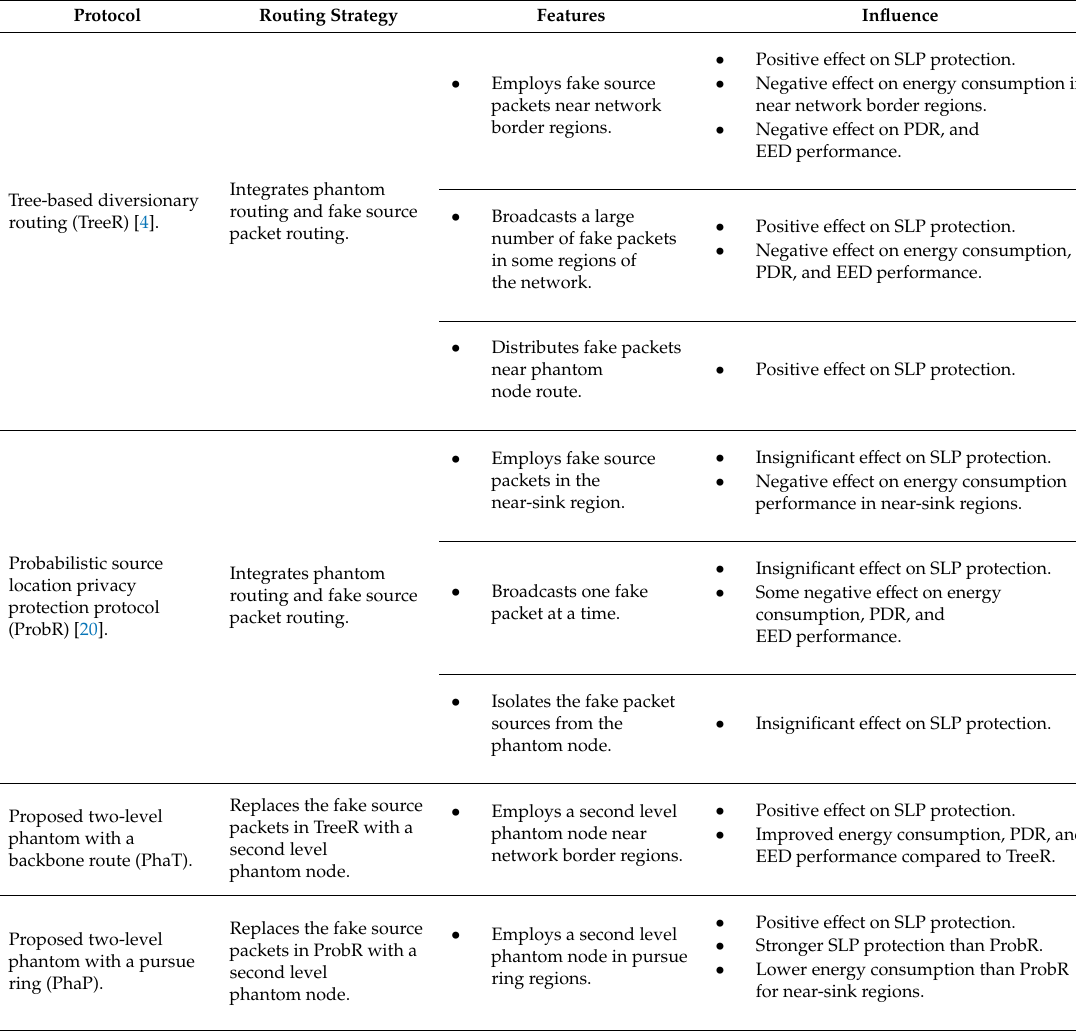
Table 1. Summary of the performance features of the existing and proposed routing protocols.